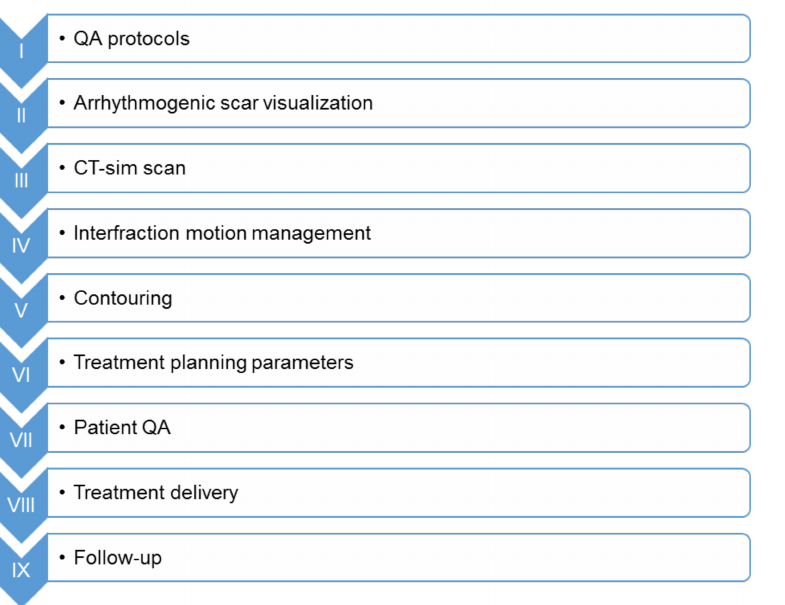
Figure 3. Stereotactic Arrhythmia Radioablation (STAR) procedural workflow. Prior treatment and the correct identification of the anatomic scar is important. QA: Quality